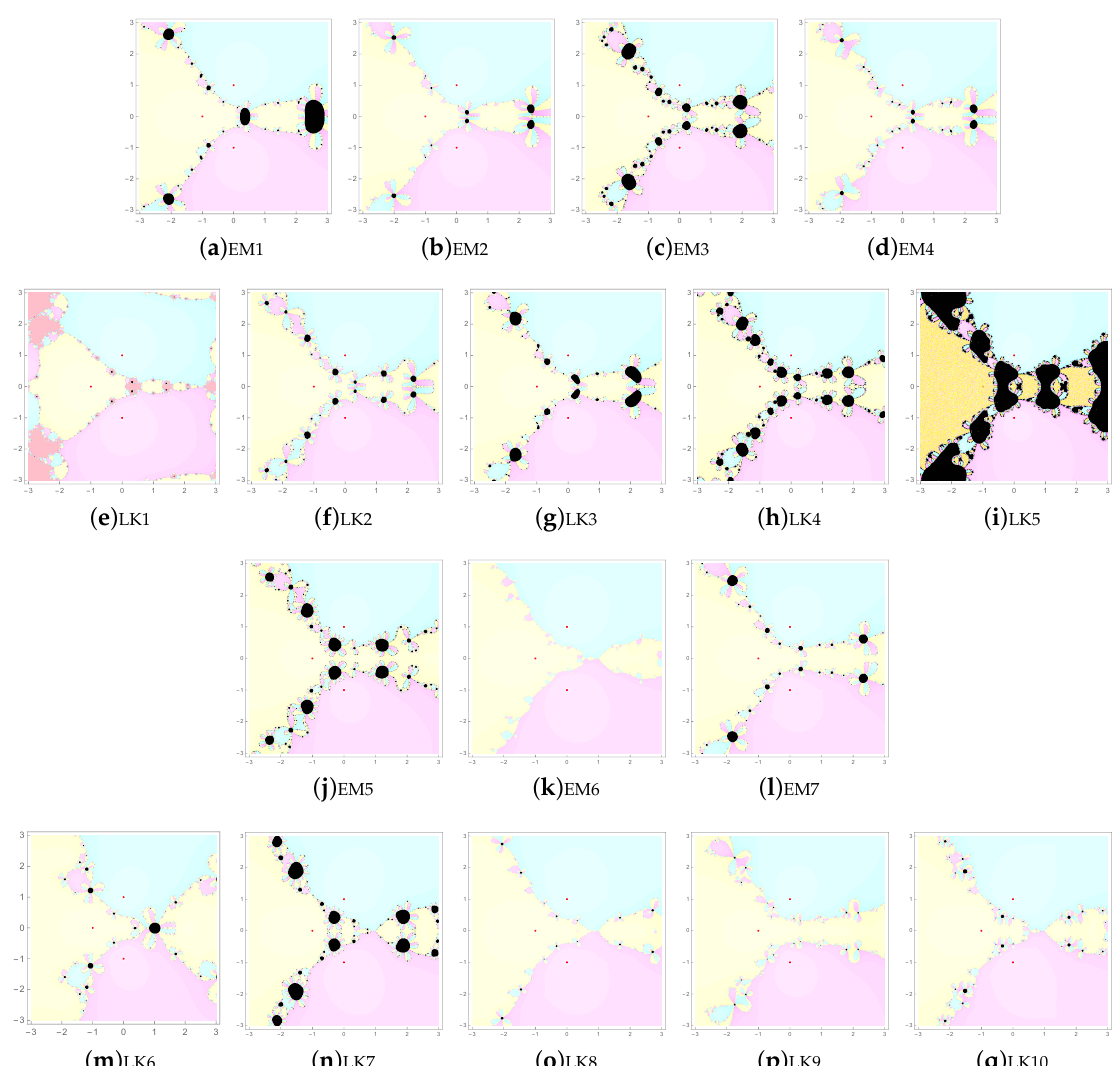
Figure 2. Basins of attraction of the listed methods, for the roots of the polynomial z 3 + z 2 + z +